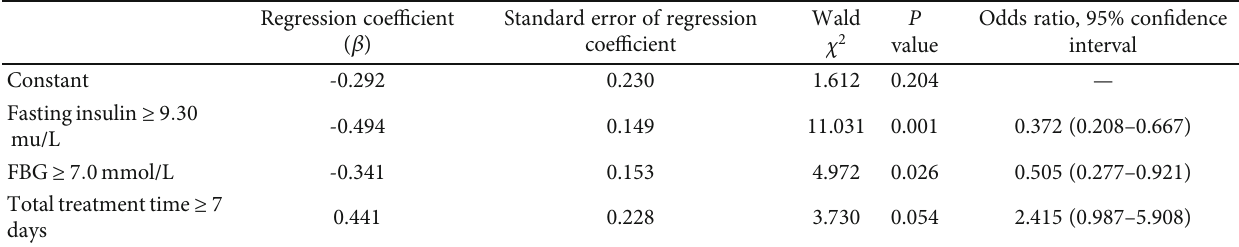
Table 2: Multivariable logistic regression analysis of multiple factors.